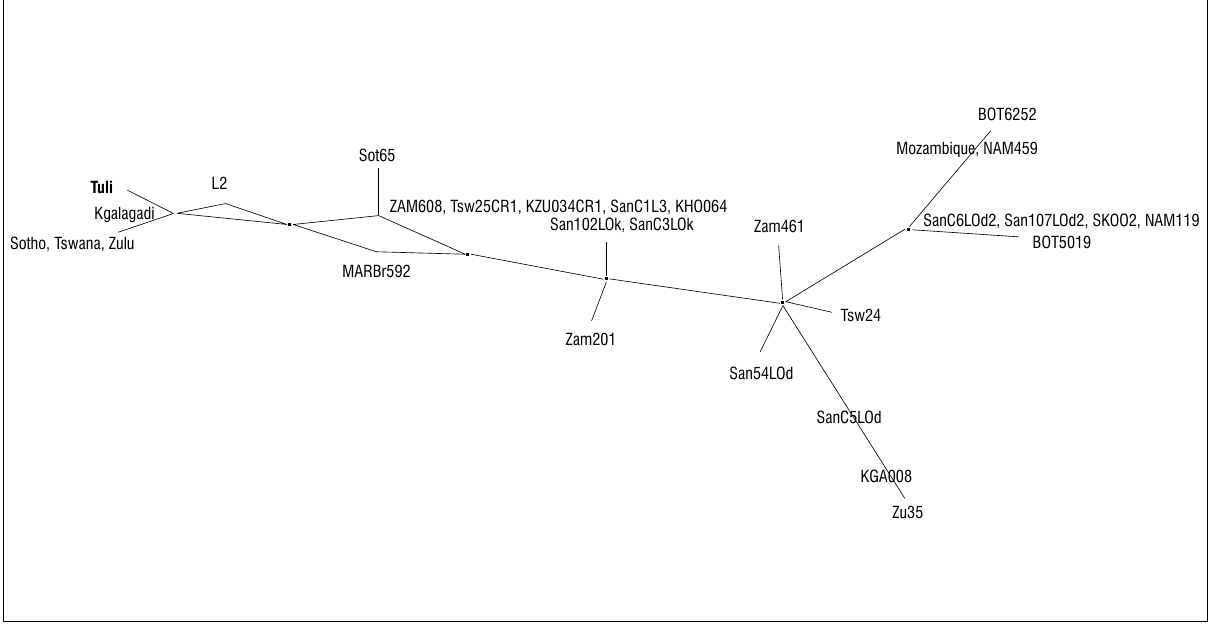
Figure 8: Network showing the relationship between the Tuli mummy and other reference sequences. The Tuli individual is marked in bold print for easier viewing. the individual was probably older than what was initially thought. This revision is supported by the observation of advanced dental wear. An age estimate of over 50 years is thus deemed to be more accurate. The Tuli mummy could not be fully evaluated based only on the available CT